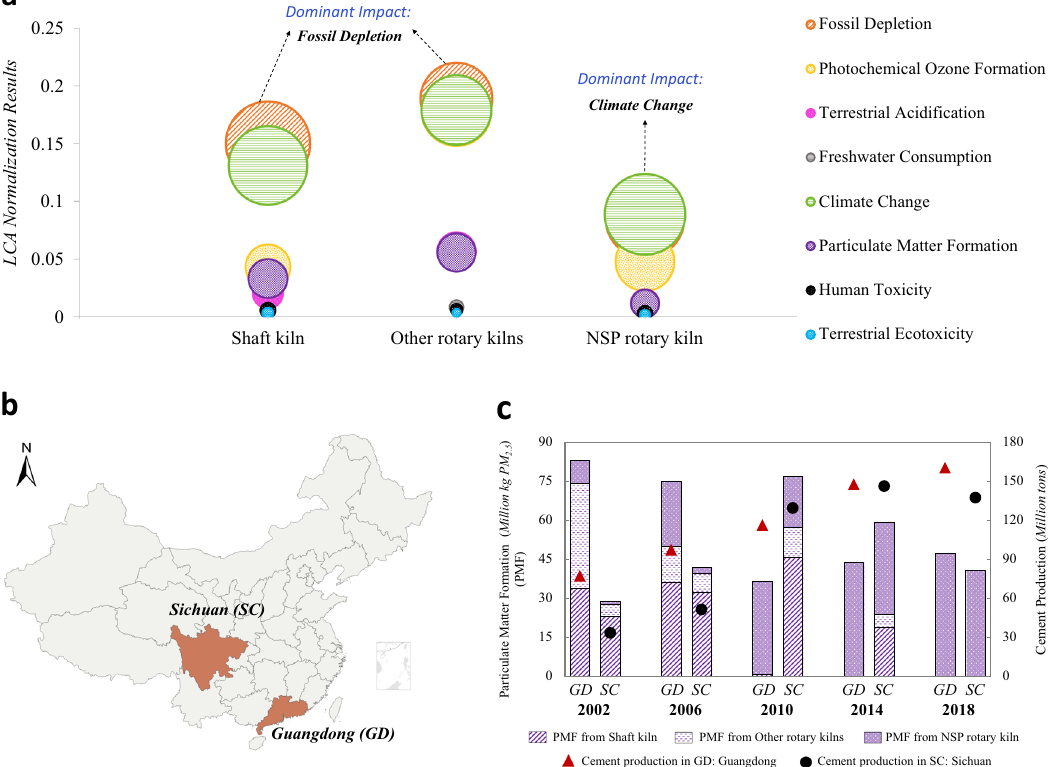
Fig. 2 Key environmental impact results of cement manufacturing in China. a compares the key environmental impacts of cement manufacturing based on three major CMTs. The bubble size represents the share of the selected impact category accounting for the sum of one CMT ’ s LCA normalization results. b shows the geographical location of two selected cases at the provincial level. c illustrates the evolution of the PMF environmental impact caused by cement manufacturing based on three cement kilns in 2002, 2006, 2010, 2014, and